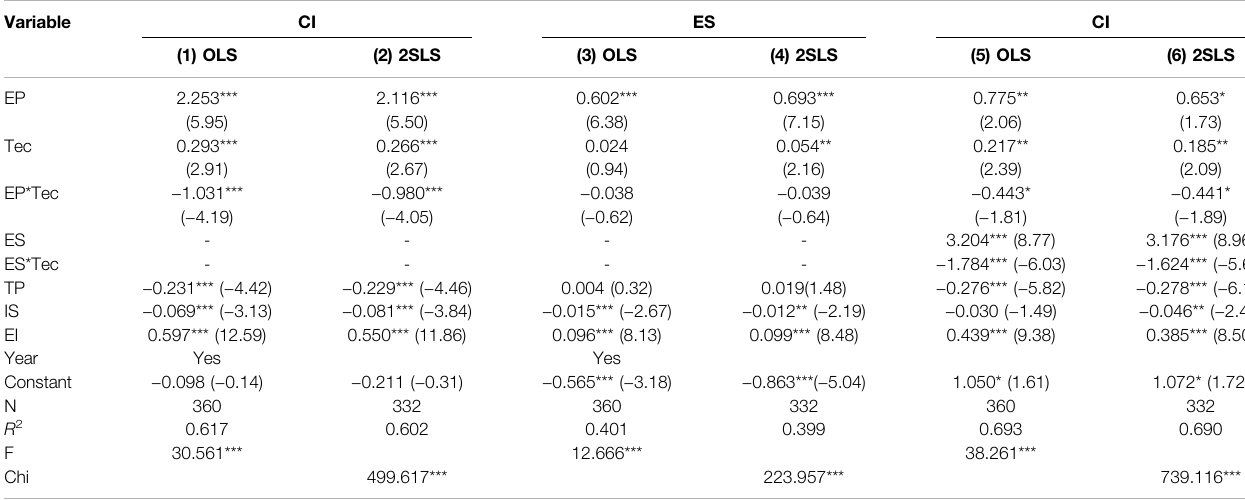
TABLE 5 | Test of moderating effect of the technical level.